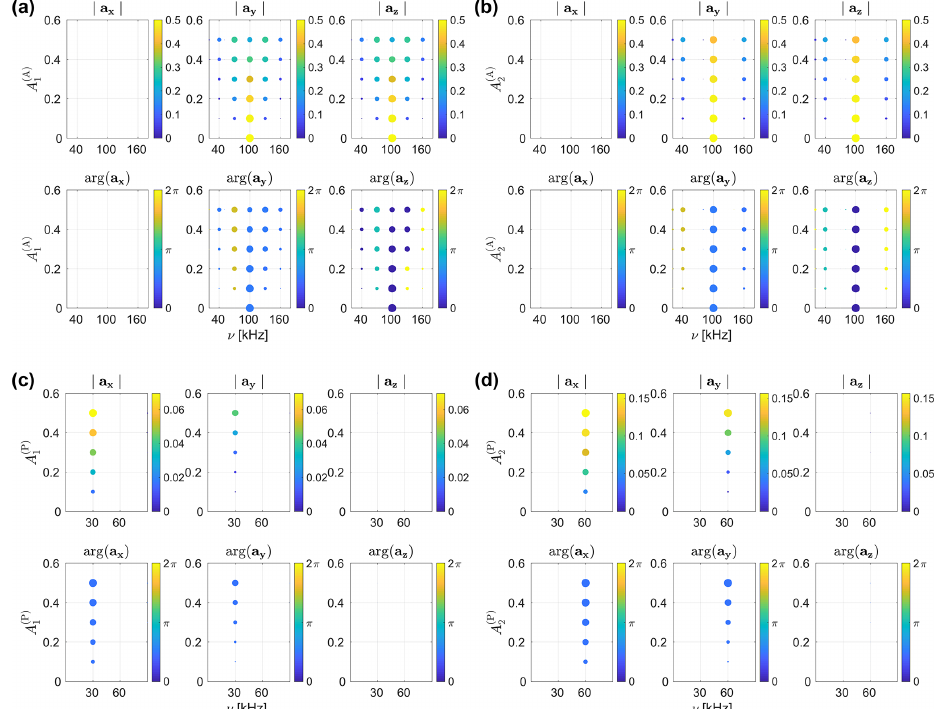
Figure 5. Absolute values and phases of the a χ ( t ) coefficients characterizing the interaction frame trajectory of the ˆ I z operator during a nutation experiment with rf irradiation along the x axis. A nominal rf field strength of 100kHz and a MAS frequency of 30kHz was assumed. The magnitude and phase of the coefficients are shown as a function of the A (A) n (a, b) and A (P) n (c, d) magnitude coefficients for rf amplitude modulations, with ω r (a) and 2 · ω r (b) , as well as phase modulations with ω r (c) and 2 · ω r (d) . Sidebands due to the MAS modulation of the rf amplitude at ν 1 ± m · ν r , with m being any integer for modulations with ω r ( A (A) with 2 · ω r ( A (A) ) is observed. The intensity of these sidebands increases with the strength of the modulation. For rf phase modulations, 2 sidebands at 0 ± n · ν r arise for modulations with n · ω r . The intensity of these sidebands increases with the strength of the modulation and considerably higher intensities are observed for higher n (note the different scaling of the colour bars for A (P) frequency axes in (c, d) were restricted to 0–90kHz since the phase modulation sidebands are significantly weaker than the main band contribution to a z ( t ) at the nominal rf amplitude of